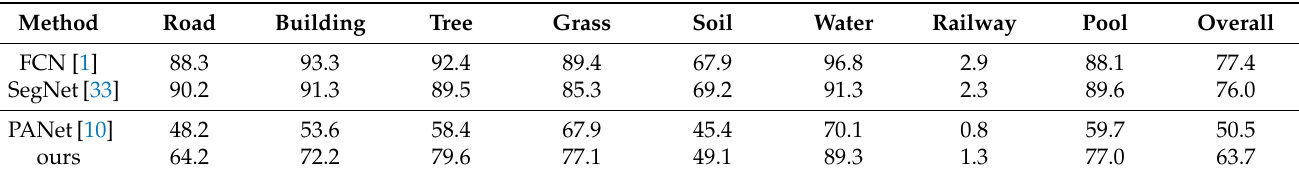
Table 5. F1 score of each class and overall accuracy on Zurich dataset (comparison between deep learning and few-shot learning of segmentation model).